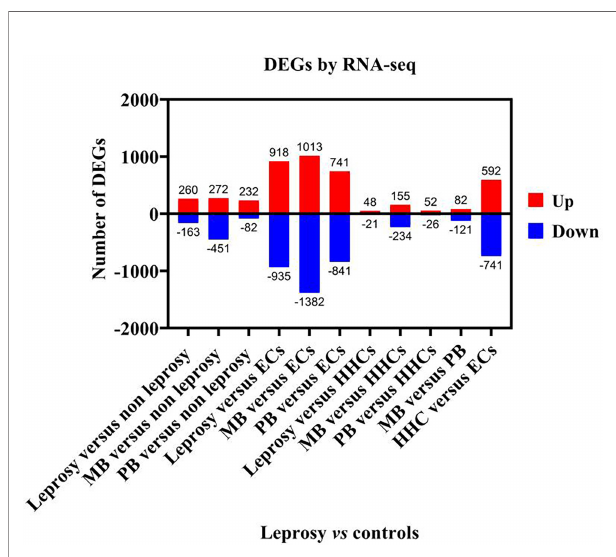
FIGURE 2 | The number of deferentially expressed transcripts altered in leprosy (MB + PB) patients compared to non-leprosy controls. DEGs, differentially expressed genes; RNA-seq, RNA sequencing; MB, multibacillary; PB, paucibacillary; HHCs, healthy house contacts; ECs, endemic